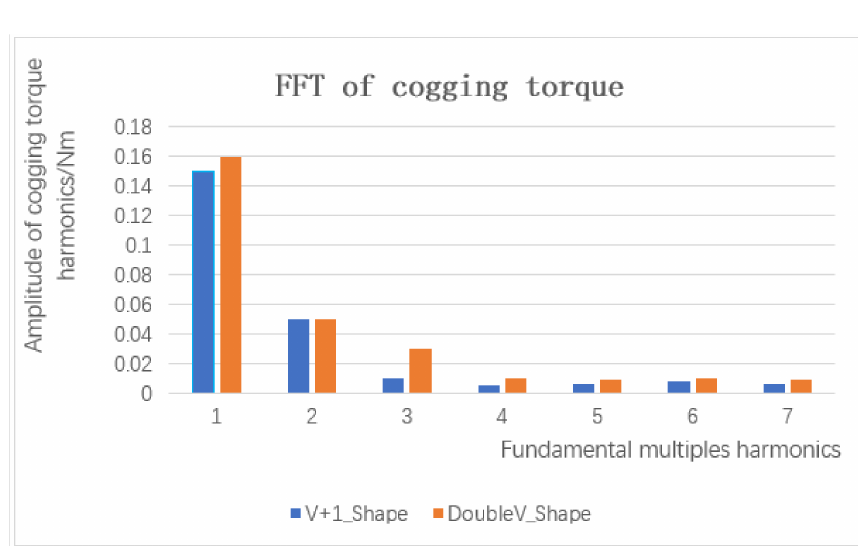
Figure 5. Cogging torque of different rotor shapes.